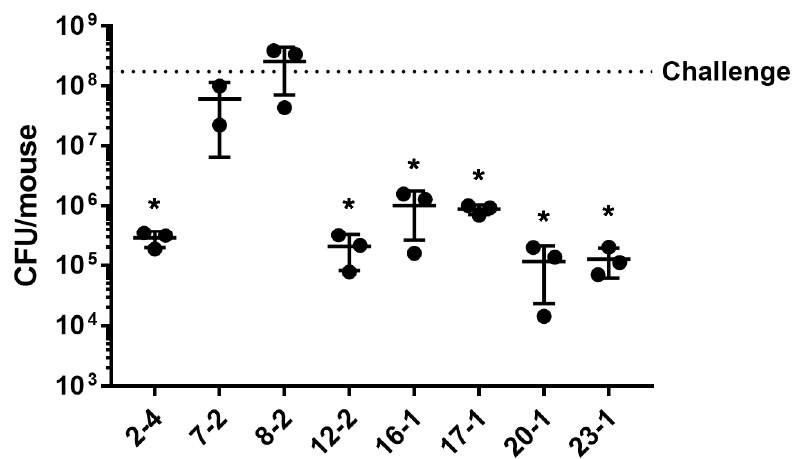
Figure 6. CFU recovered from WT mice lungs at 24 h after intratracheal challenge with eight clinical isolates. The bacterial load used for the challenge is indicated (dotted line). The mean ± SD of three mice per group is shown. Statistical analysis of each isolate vs. challenge was performed by 1way ANOVA test; * p < 0.05.